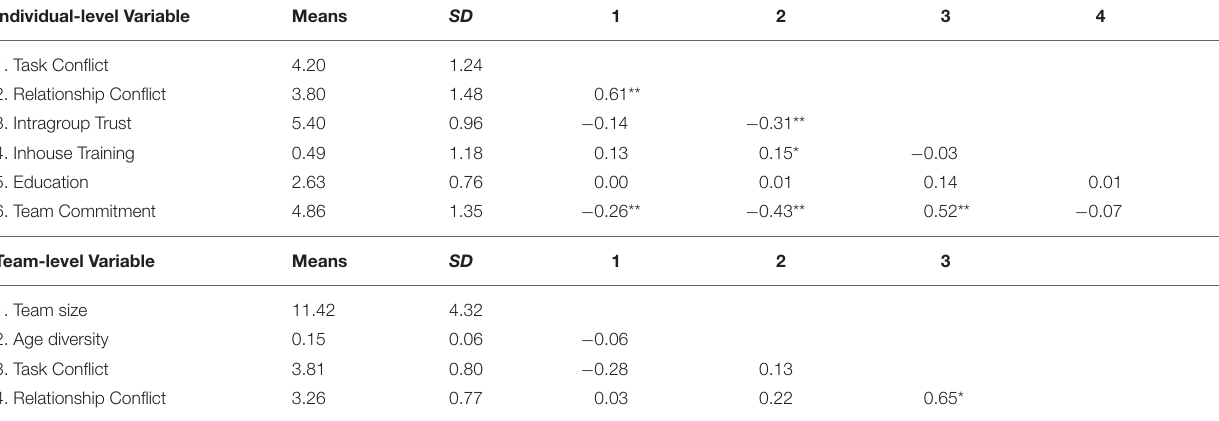
TABLE 1 | Means, standard deviations, and correlations for variables.